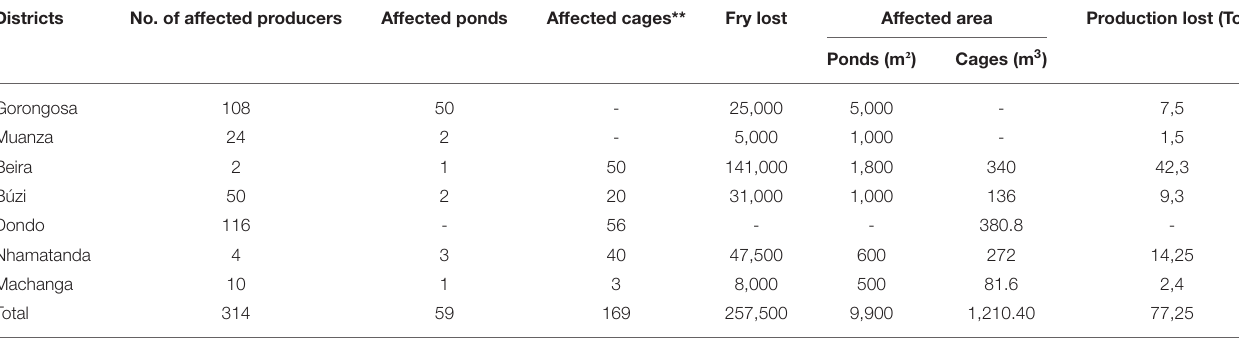
TABLE 2a | Summary of impacts of cyclone Idai and Kenneth on the aquaculture sector in Sofala Province (a) and Zambézia (b).